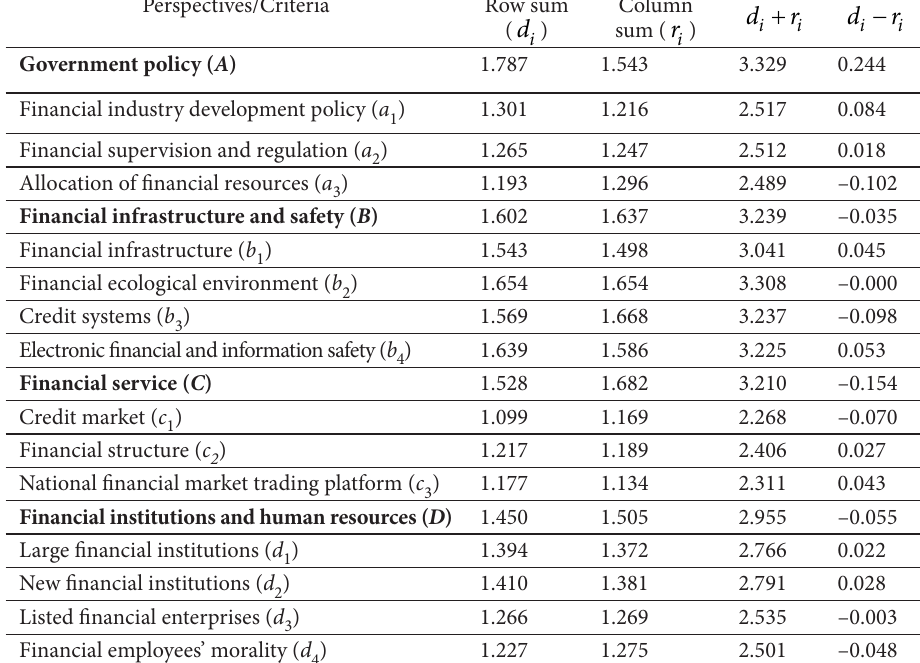
Table 5. The sum of the influences given and received on the perspectives and criteria Perspectives/Criteria Row sum ( i d